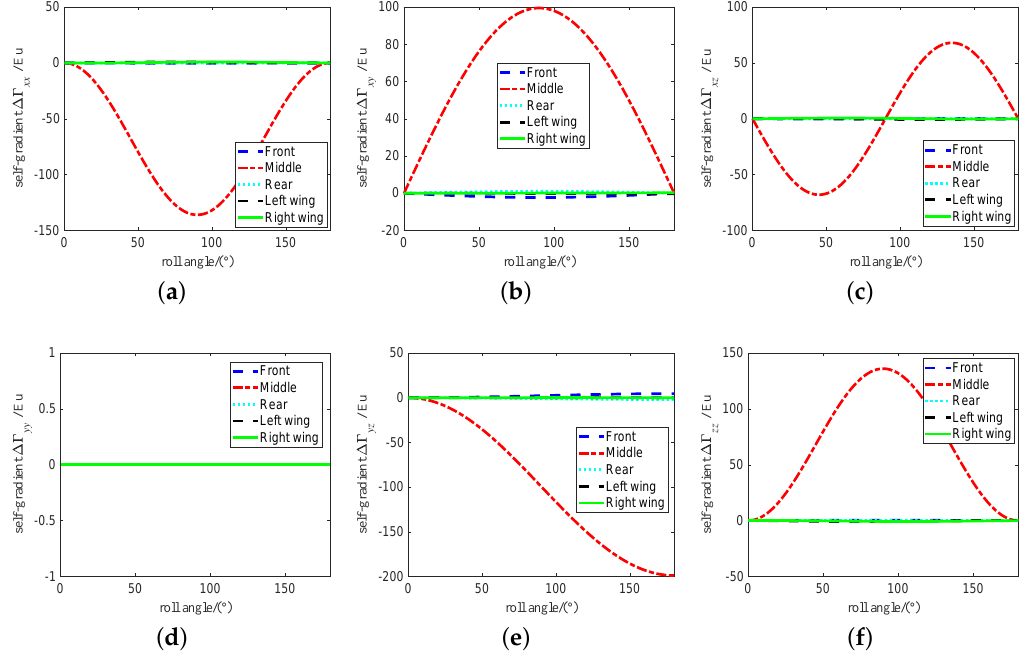
Figure 6. Self-gradient caused by the distribution mass of the carrier in roll attitude. ( a ) Self-gradient element Γ xx . ( b ) Self-gradient element Γ xy . ( c ) Self-gradient element Γ xz . ( d ) Self-gradient element Γ yy . ( e ) Self-gradient element Γ yz . ( f ) Self-gradient element Γ zz